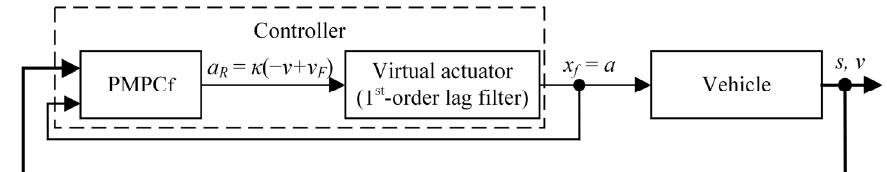
Figure 6. Block diagram of parallel MPC with virtual actuator.